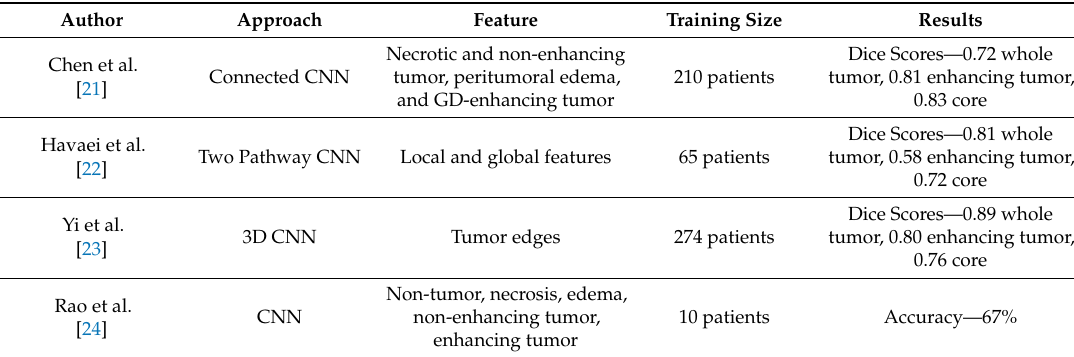
Table 1. Machine learning architectures and approaches used to segment both pre-operative and post-operative GBMs. Dice score (Sørensen-Dice coe ffi cient) is a statistic used for comparing the spatial overlap of two binary images and is routinely used for tissue classification assessment. Dice scores closer to 1 indicate stronger overlap and accuracy